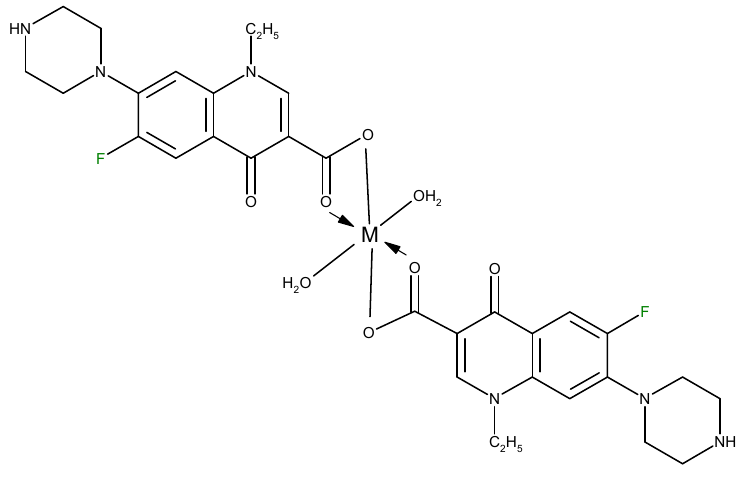
Figure 6. The proposed structure of complexes of Fe(III)-Nf and Co(II)-Nf (adapted from [108]).